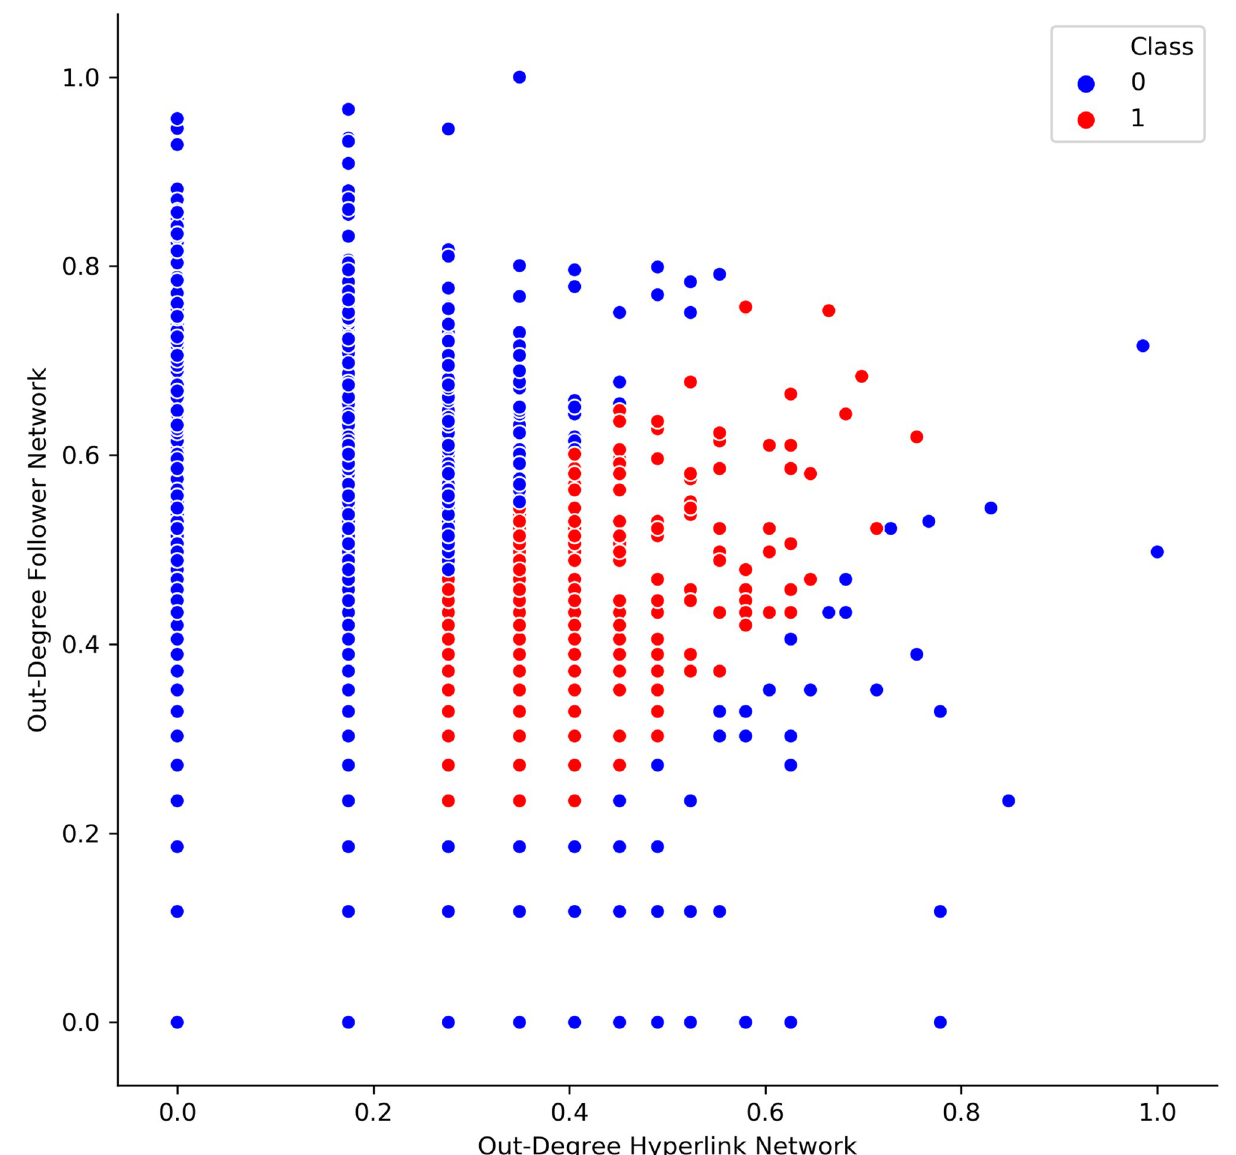
Fig 3. Categorizing data with the help of sliding